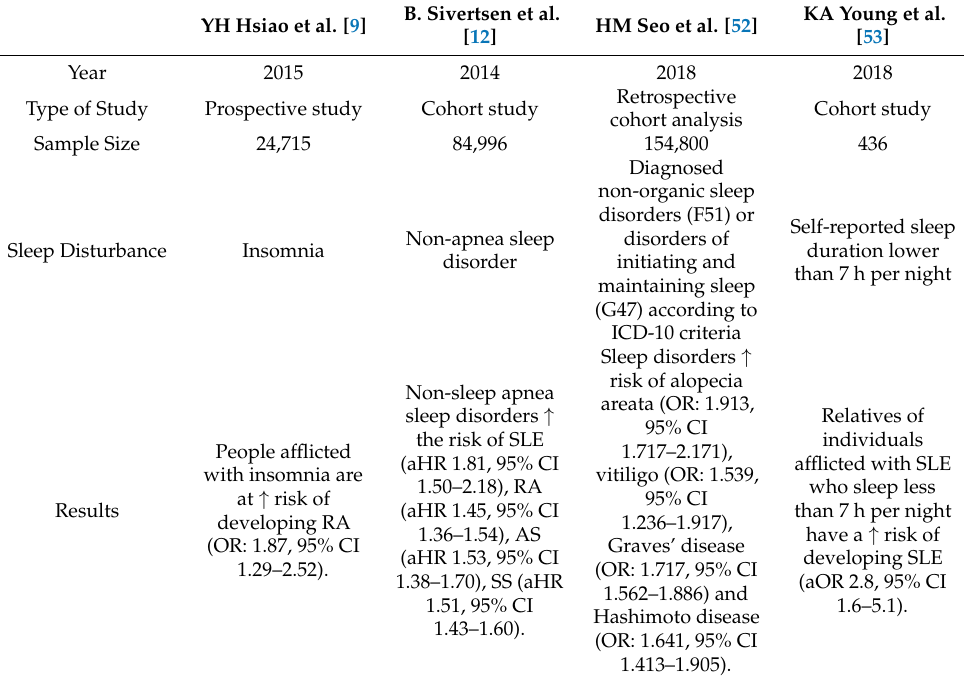
Table 2. Sleep disturbances and risk of immune-mediated diseases. B. Sivertsen et al. YH Hsiao et al. [9]